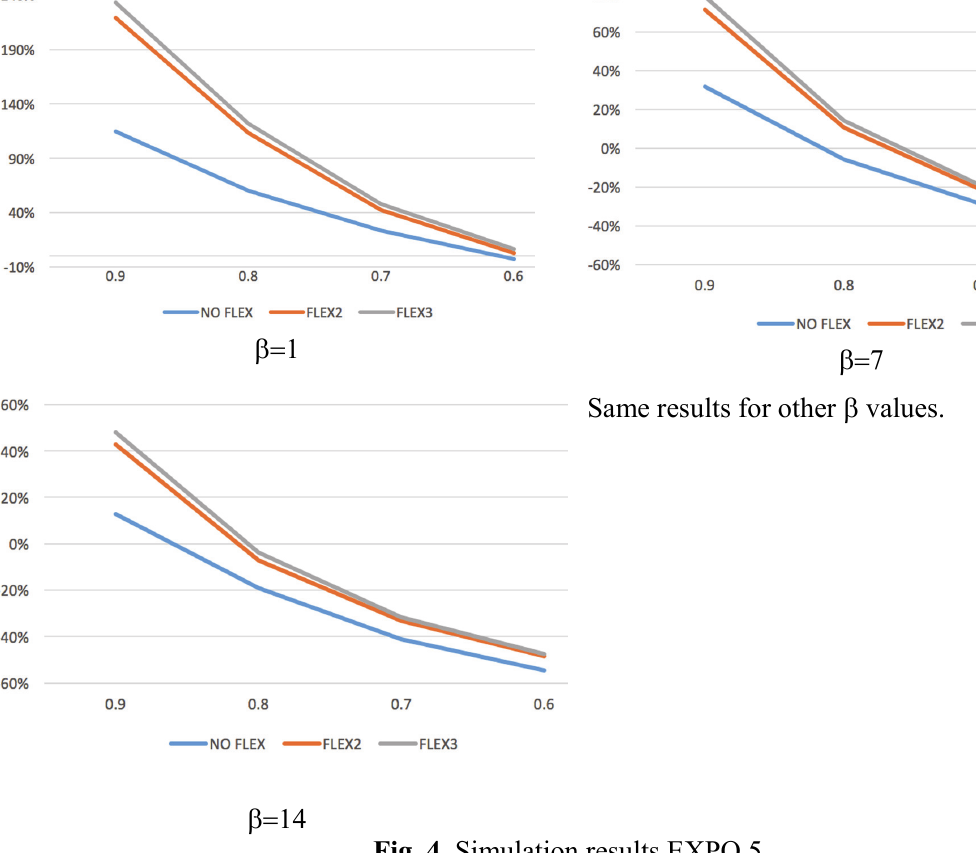
Fig. 4. Simulation results EXPO